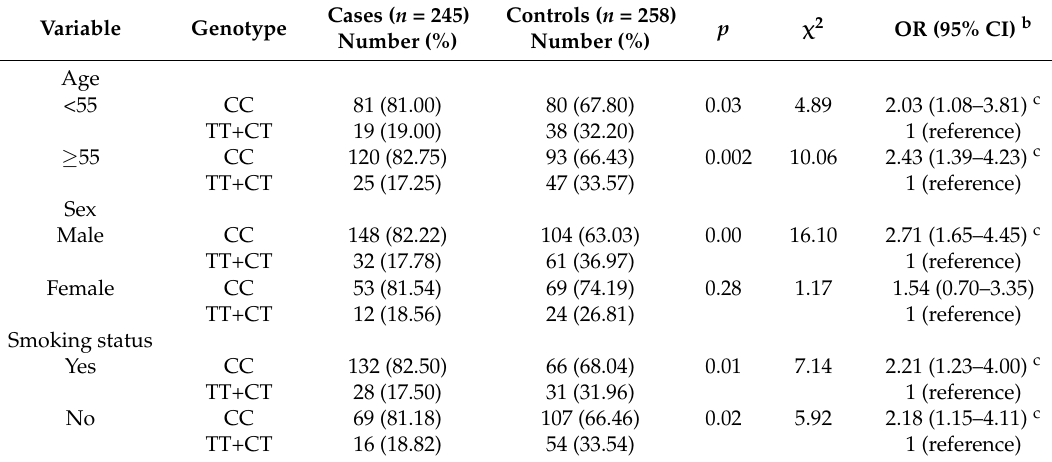
Table 2. Associations with MMP9 polymorphisms in non-small cell lung cancer (NSCLC) and control groups.